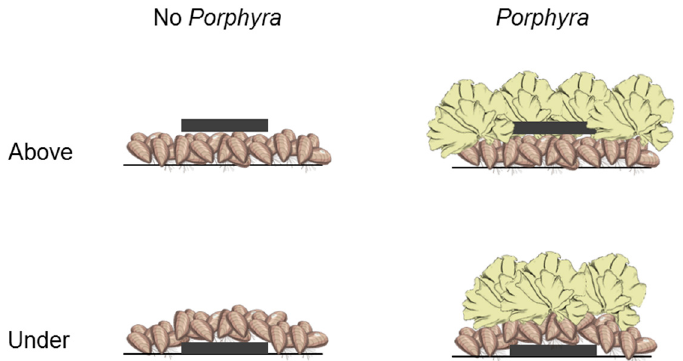
Figure 2. Treatments in the factorial experiments conducted to evaluate the effect of Porphyra cover (Yes/No) and place of measurement (Above/Under the mussel layer) on temperature and desiccation. The bold black line indicates the position of the standard material used to measure temperature and desiccation (Plastic cards wrapped with black electrical tape and water-saturated pieces of absorbent cleaning cloth, respectively).